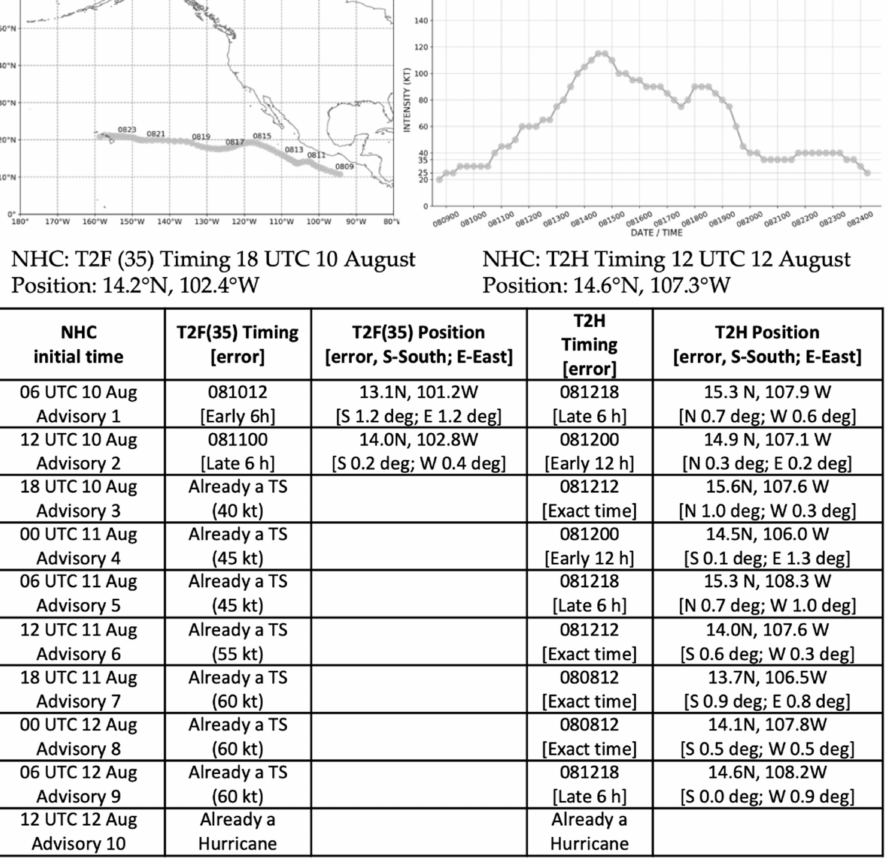
Figure 1. National Hurricane Center (NHC) Working Best Track (WBT) track and intensities are provided at top to assist in evaluating the NHC forecasts of the T2F(35) and the T2H timing and positions during pre-Linda extracted from the NHC advisories, which are typically each 6 h unless a Special Advisory is issued. Timing errors and position errors relative to the verifying T2F(35) and T2H values at the top of the table are provided within the brackets on the line below the